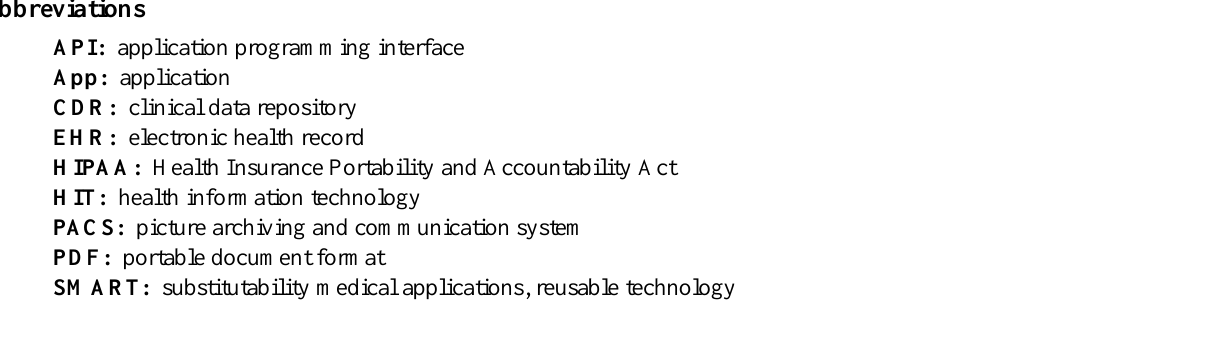
clinical decision support systems in specialty hospitals: protocol for a qualitative cross-sectional study. Implement Sci 2014;9:105 [FREE Full text] [doi: 10.1186/s13012-014-0105-0] [Medline: